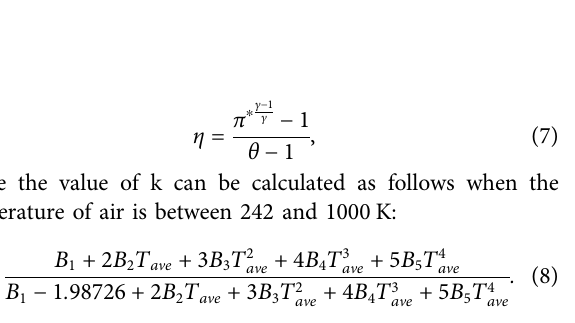
FIGURE 8 | Changing curves of compressor performance parameters related to the seal leakage at different rotation speeds. Δ G equ /G DP related to Φ (A) , Δπ stall / π Φ (B) , Δη Φ (C) , Δ SM related to Φ (D) . DP related to top related to